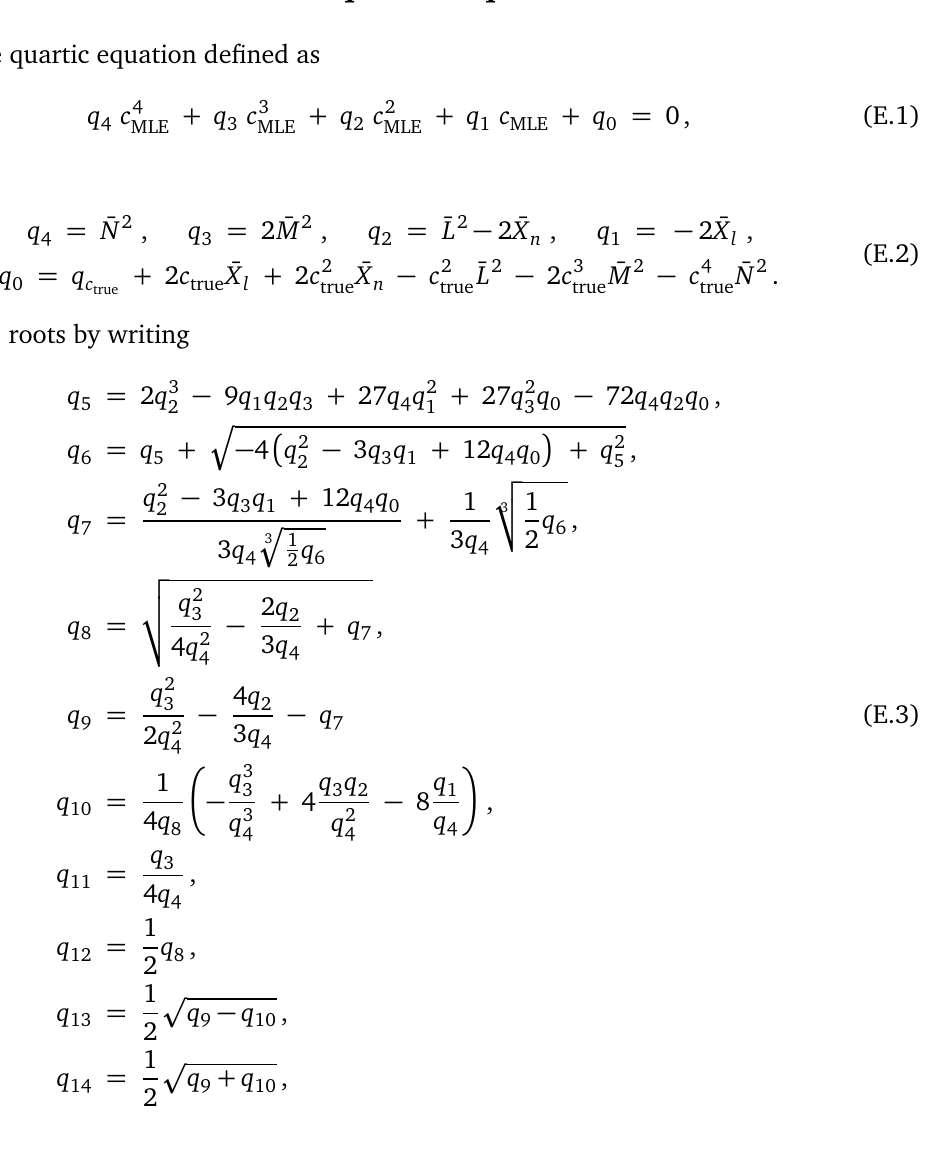
as a function of c MLE